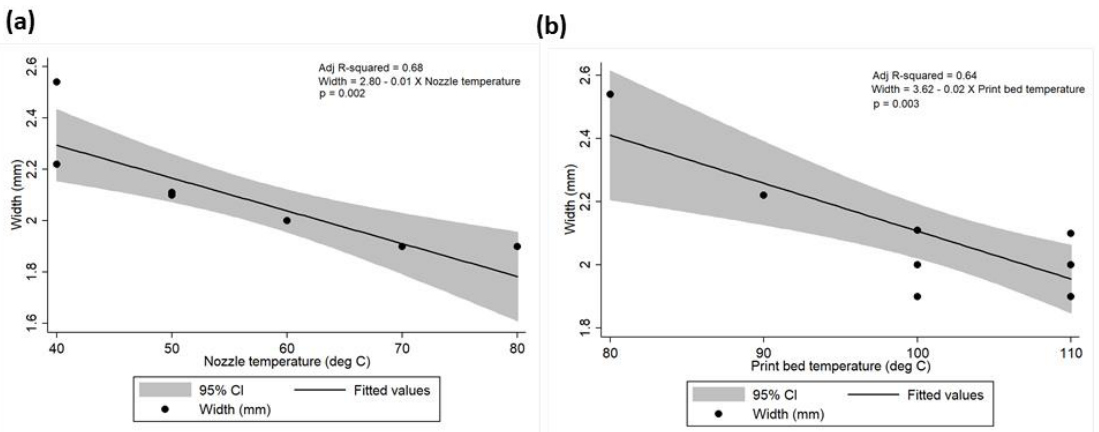
Figure 11. Correlation between meniscus width and ( a ) nozzle temperature and ( b ) print bed temperature.